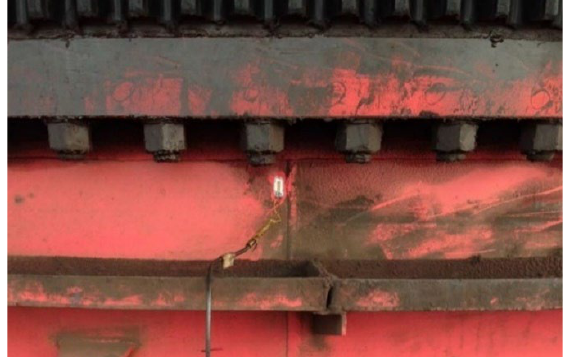
Figure 11. The actual location and method of laying the strain gauges.